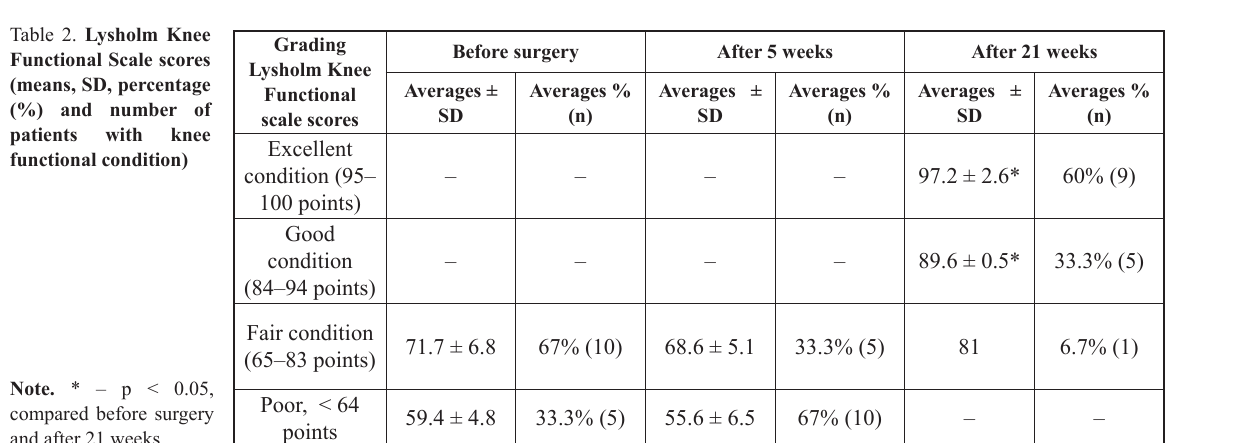
1. Difference in seconds (%) in movement coordination test for timescale mean (averages ± SD) between injured knee and uninjured knee Note. * – p < 0.05, injured and uninjured knee compared.